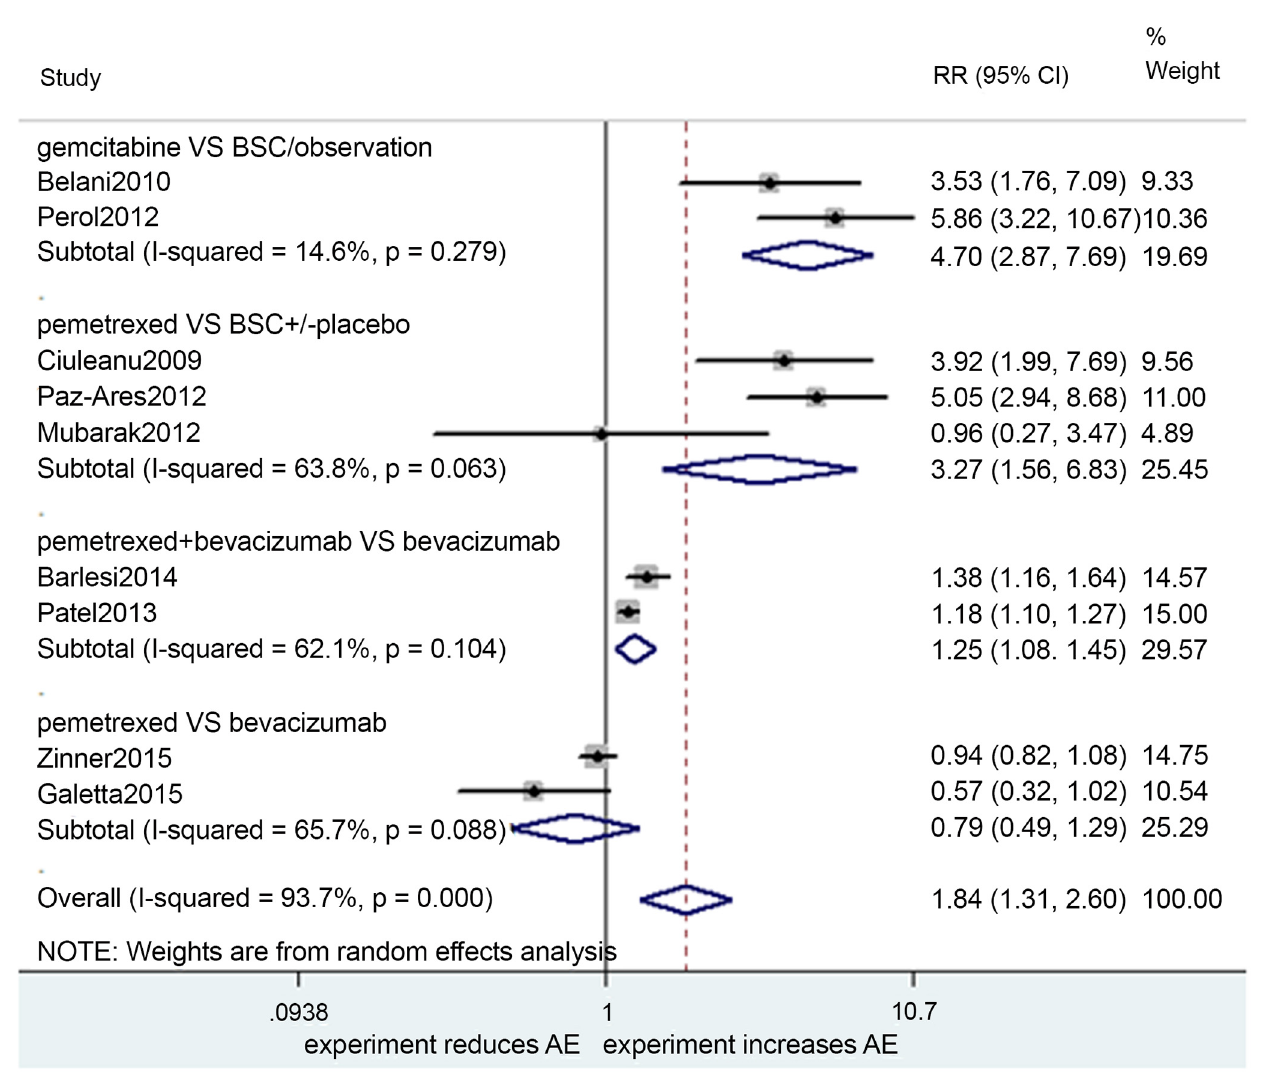
Fig 5. Meta-analysis results of grade 3 – 4